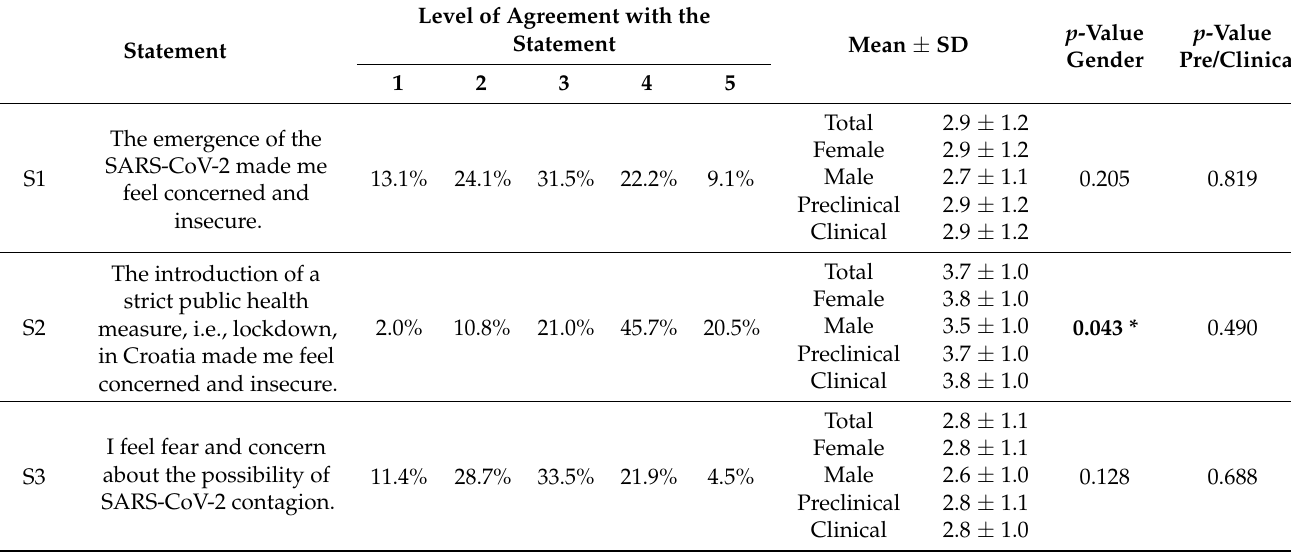
Table 2. The self-perceived psychoemotional impact of the COVID-19 pandemic.